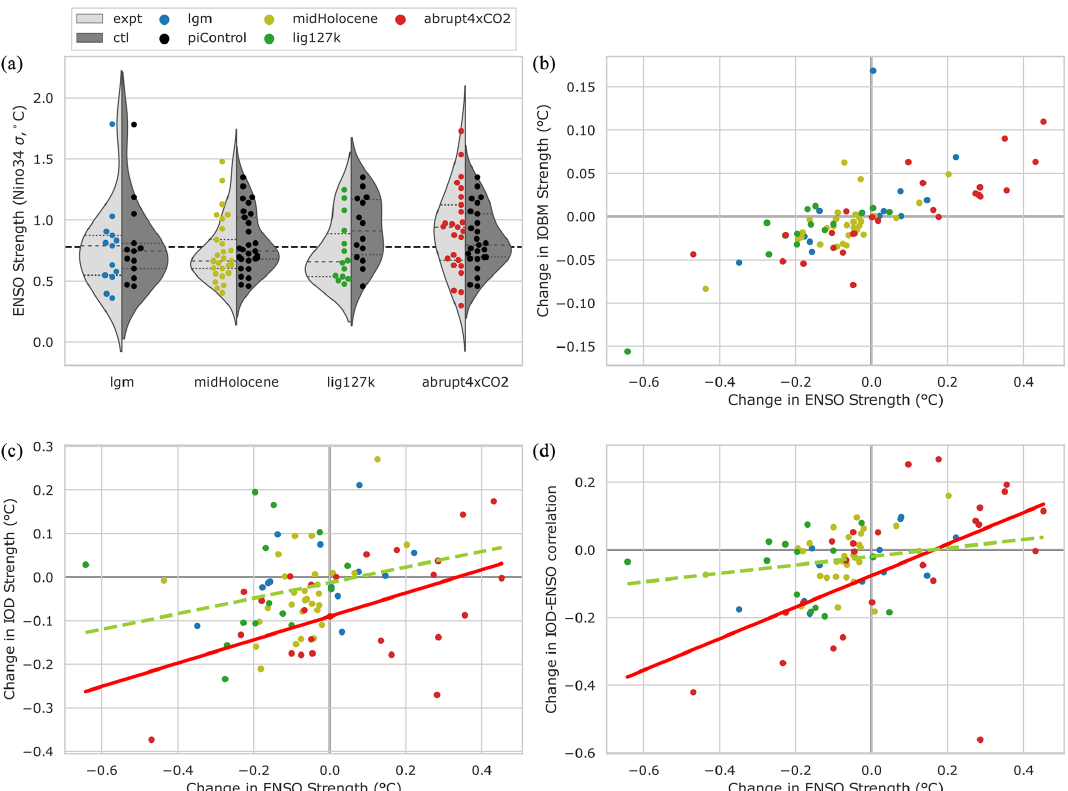
Figure 7. Relationships between the amplitude changes in modes of Indian Ocean variability and the mean state. (a) The amplitude of Pacific ENSO is measured by the standard deviation of the Niño3.4 SST anomalies (Sect. 2.3). (b) Amplitude changes in the IOBM are strongly related to changes in ENSO amplitude. (c) Amplitude changes in the IOD show some signs of being related of changes in ENSO amplitude. (d) There is a weak indication suggesting that as ENSO amplitude becomes larger, its correlation with the IOD also strengthens. The red solid lines show a statistically significant linear relationship in the abrupt4xCO2 experiment. Yellow–green dashed lines show the linear regressions across the two orbital experiments that are not statistically